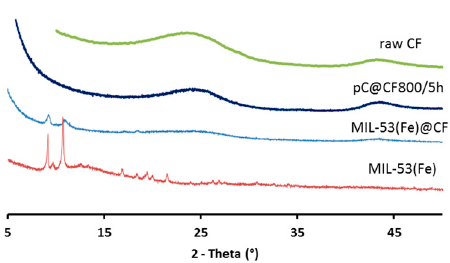
Figure 2. XRD patterns of raw CF, pC@CF800 / 5h electrode, virgin MIL-53(Fe)@CF sample and MIL-53(Fe) powder.